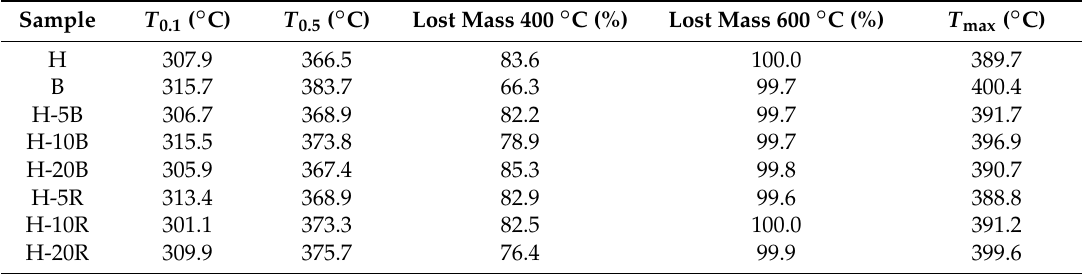
Table 8. Thermogravimetric results for membranes of PP homopolymer and blends with random and block copolymers.